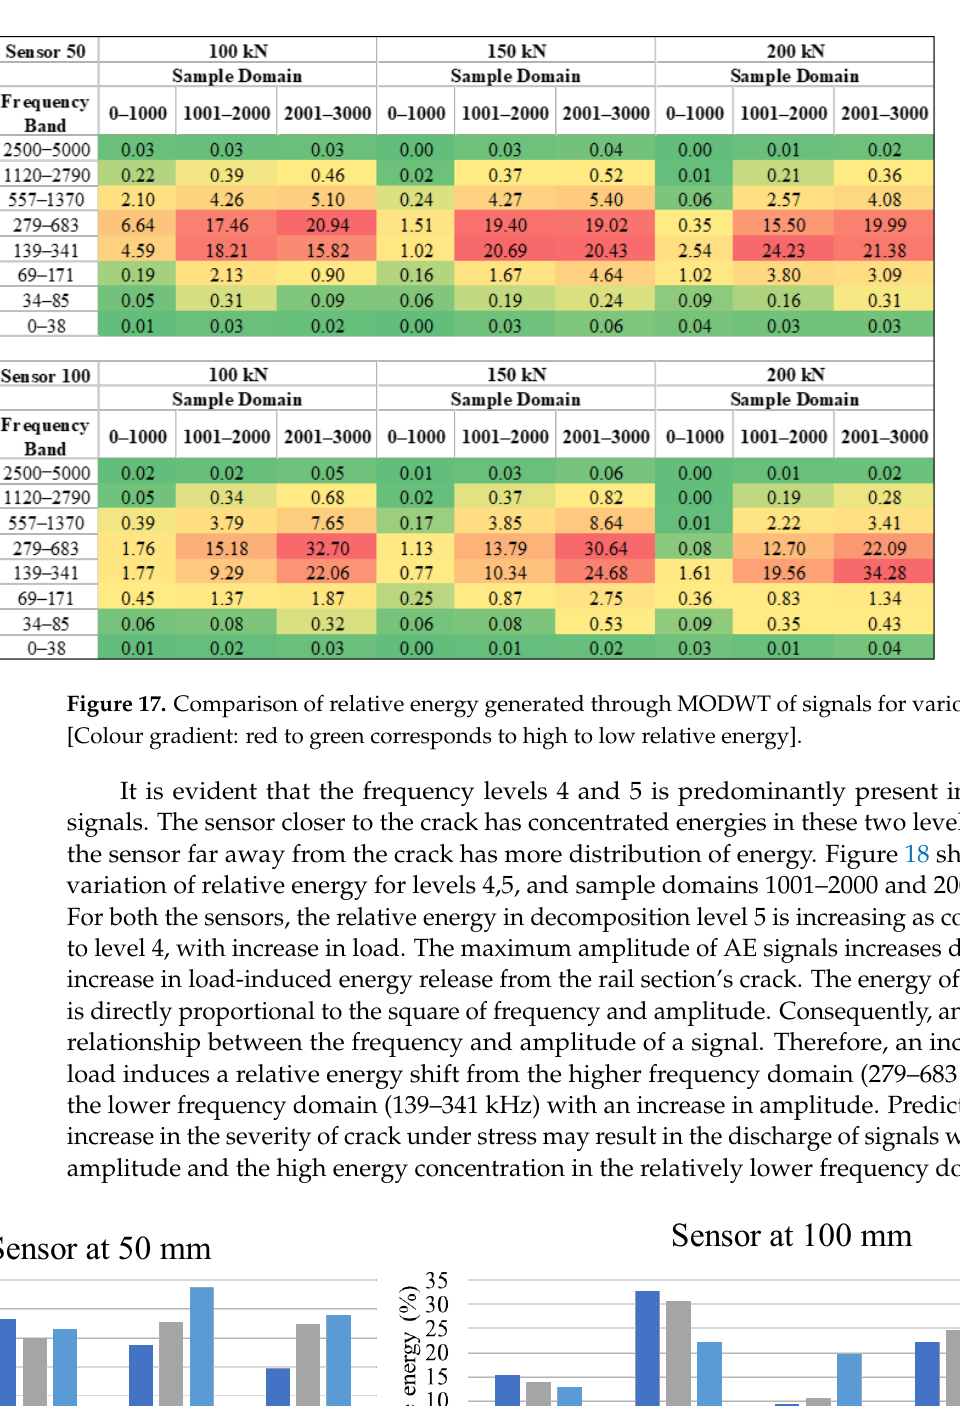
Figure 19. Variation of PAR and crack opening displacement with respect to load.